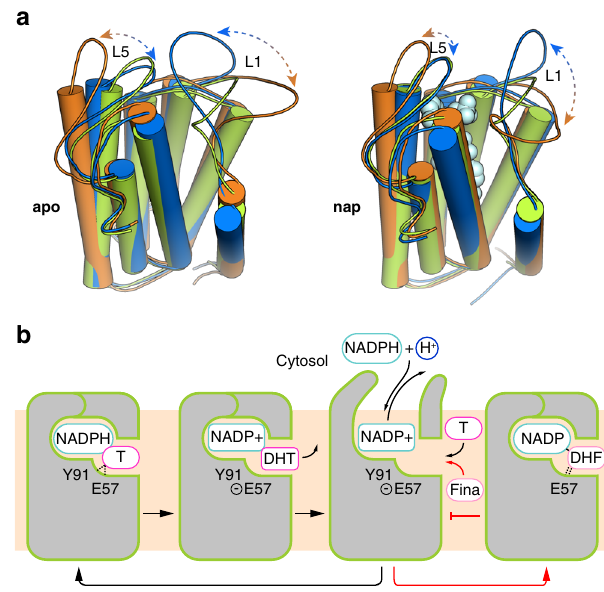
Fig. 4 Dynamics of SRD5A2 during reaction. a Dominant conformational motions in the SRD5A2 MD simulations using principal component analysis (PCA). To visualize the motions, two representative conformations from the principal components for the apo and nap states are indicated in orange and blue, respectively. The SRD5A2 crystal structure colored in green is superimposed as a reference. PCA clearly indicates large-scale motions in L1 and L5, suggesting opening up of the nucleotide-binding cavity. b Model of the dynamics of SRD5A2 in one cycle of reaction. The reaction can be inhibited by fi nasteride by forming a stable adduct with the NADPH cofactor to stabilize the closed conformation of SRD5A2. Testosterone and fi nasteride are indicated as “ T ” and “ Fina ” , respectively. Testosterone catalysis and the fi nasteride inhibition are shown with black and red arrows,